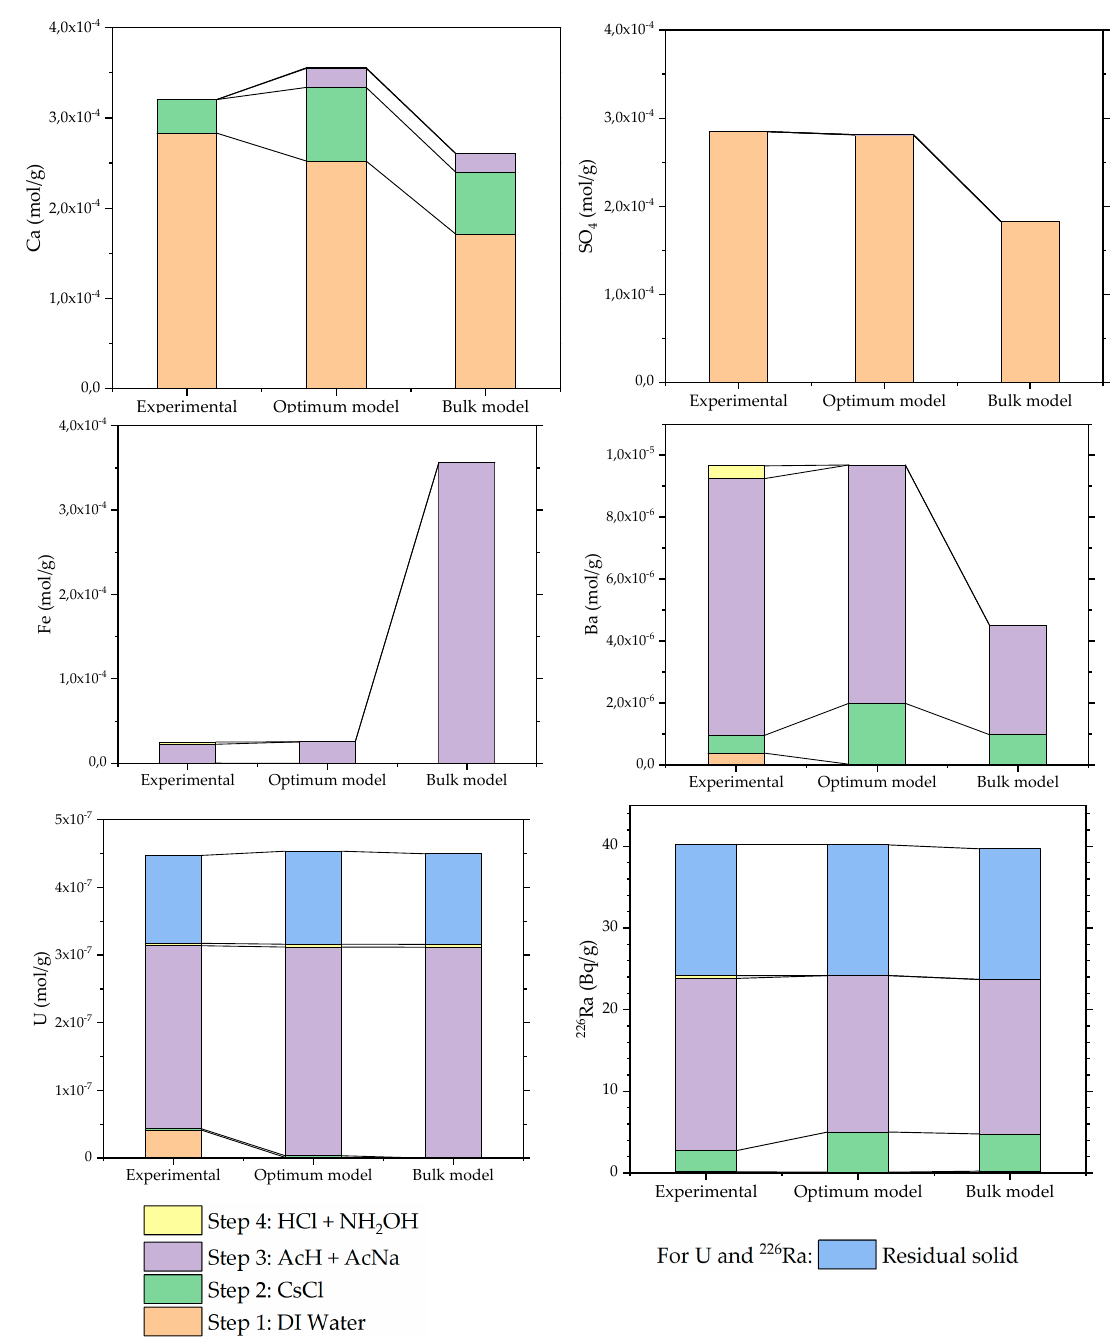
Figure 5. Extraction results for experimental data extractions (Chautard et al. [22]) and this study’s model optimized (“optimum model”) and built from bulk data (“bulk model”) for Ca, SO 4 , Fe, Ba, U and 226 Ra per g of solid for the C1P3B sample.